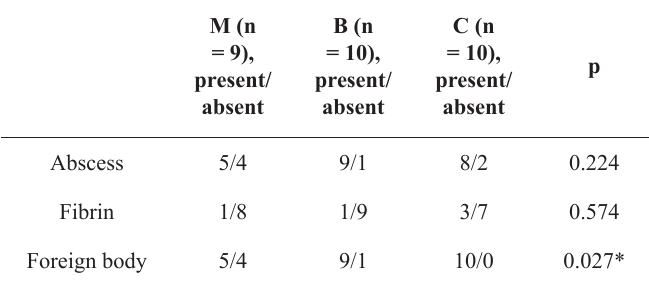
TABLE 2 - Maximum, minimum, and median (m) scores of histopathological analysis of abdominal wall scar samples; animals killed seven days after surgery. Groups M (metoclopramide), B (bromopride) and C (control).